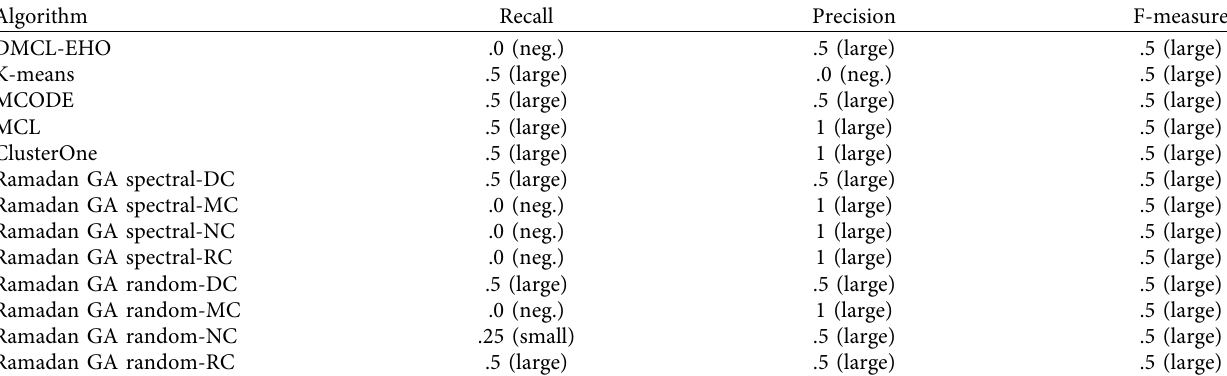
Table 11: Cliff’s δ effect size test.